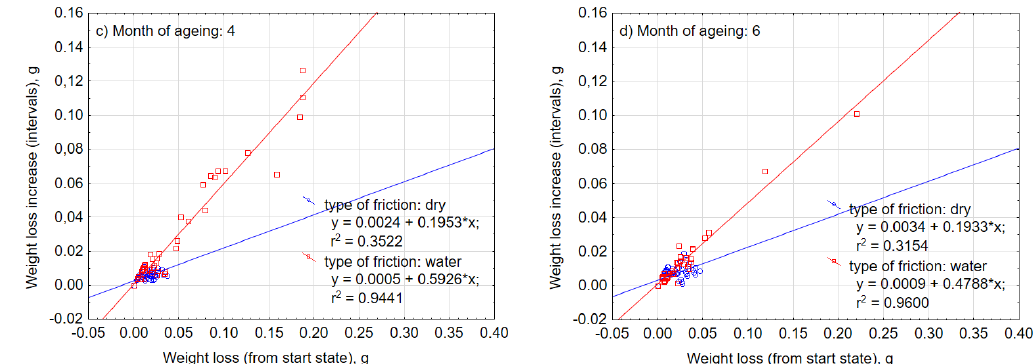
Figure 8. Scattering of the measurements of composite weight loss after ( a ) 0, ( b ) 2, ( c ) 4, and ( d ) 6 months of UV-A impact.